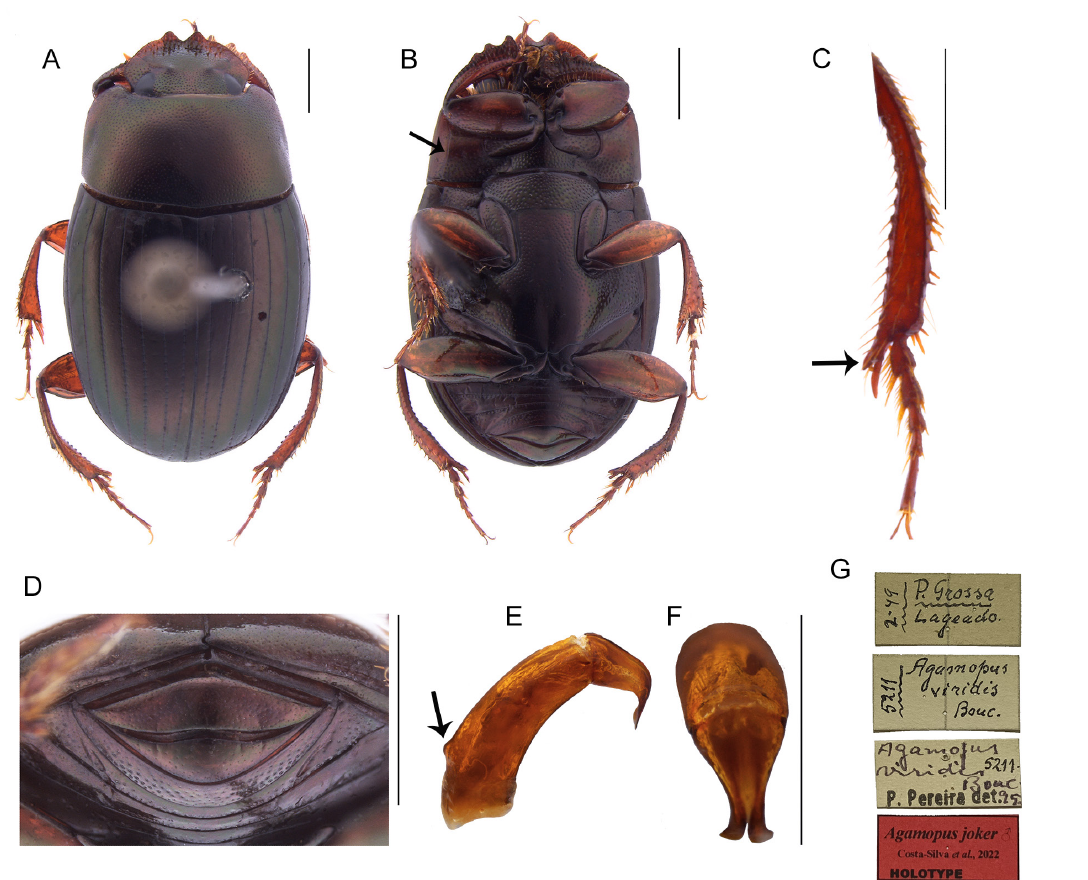
Fig. 4. Agamopus joker sp. nov. Holotype, ♂ (CEMT). A . Habitus, dorsal view. B . Habitus, ventral view (black arrow indicating the longitudinal keel slightly marked). C . Hind tibia (black arrow indicating the elongate apical process in the metatibia). D . Sulcus in the pygidium. E . Aedeagus, lateral view (black arrow indicating the gibbosity near base). F . Aedeagus, dorsal view. G . Labels. Scale bars = 1